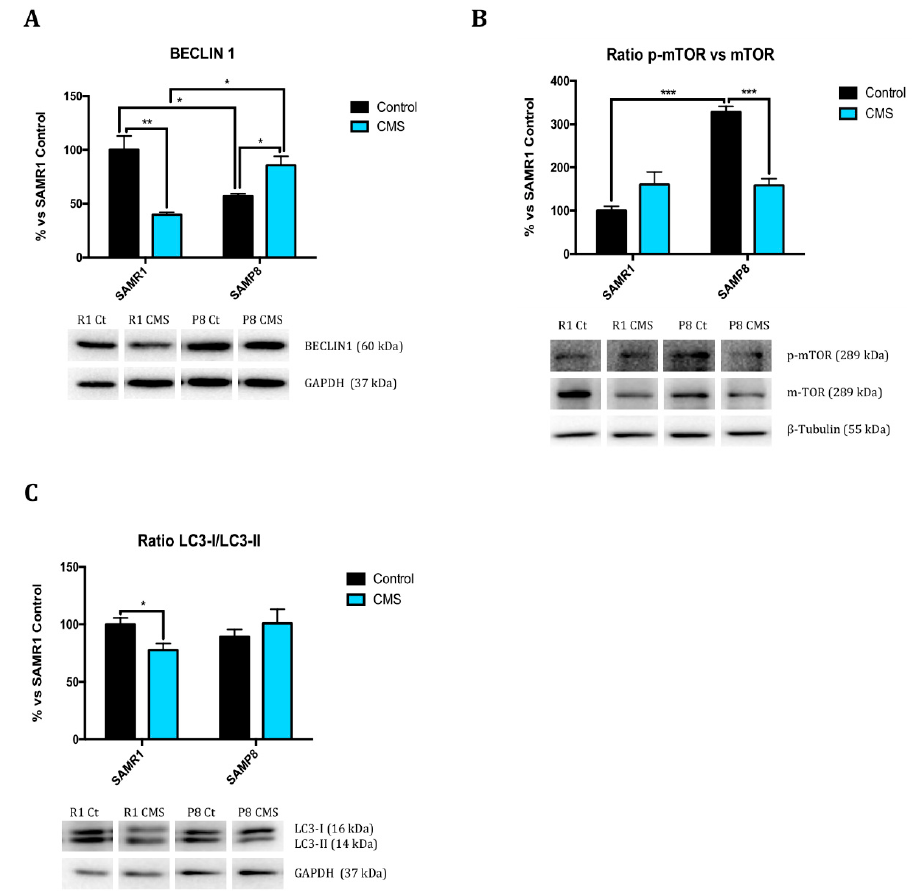
Figure 6. CMS induced autophagy flow modifications in SAMR1 and SAMP8 . Representative Western Blot for Beclin 1 protein levels and quantification ( A ), the ratio of p-mTOR protein levels and quantification ( B ) and the ratio of LC3 protein levels and quantification ( C ). Values in bar graphs are adjusted to 100% for protein levels of SAMR1 control (R1 Ct). Values are mean ± Standard error of the mean (SEM); ( n = 4 for each group). * p < 0.05; ** p < 0.01; *** p < 0.001.